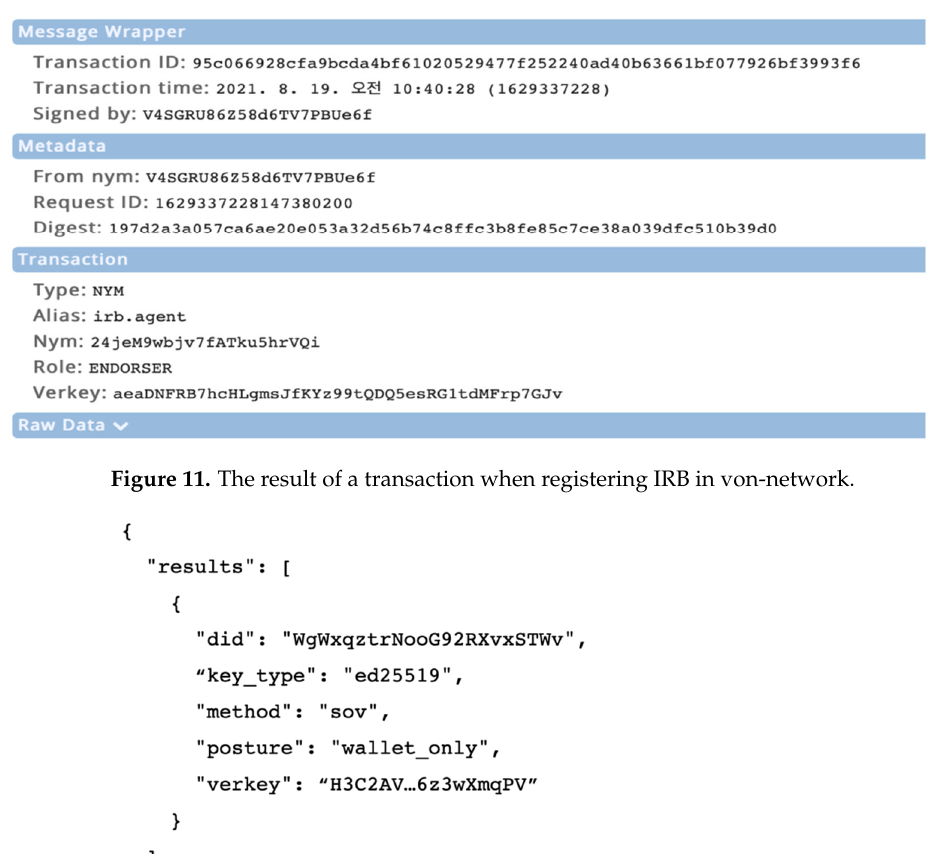
Figure 12. The example of the DID of a researcher.